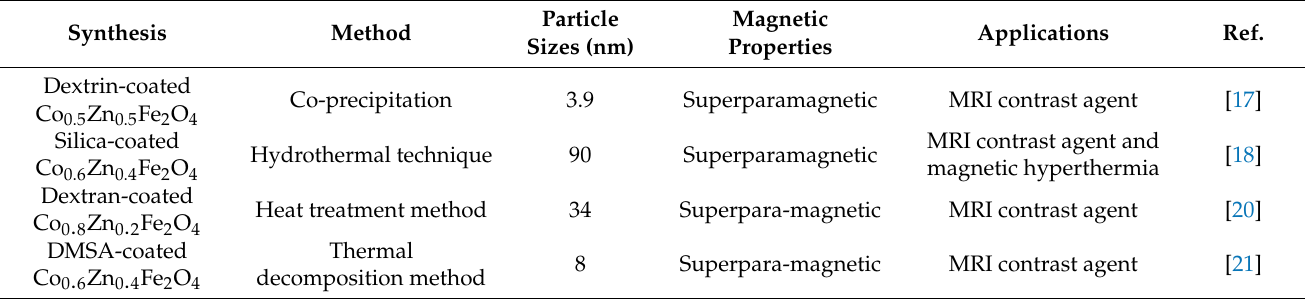
Table 1. Literature review of synthesis methods for cobalt–zinc ferrite (Co 1 − x Zn x Fe 2 O 4 ) and features.